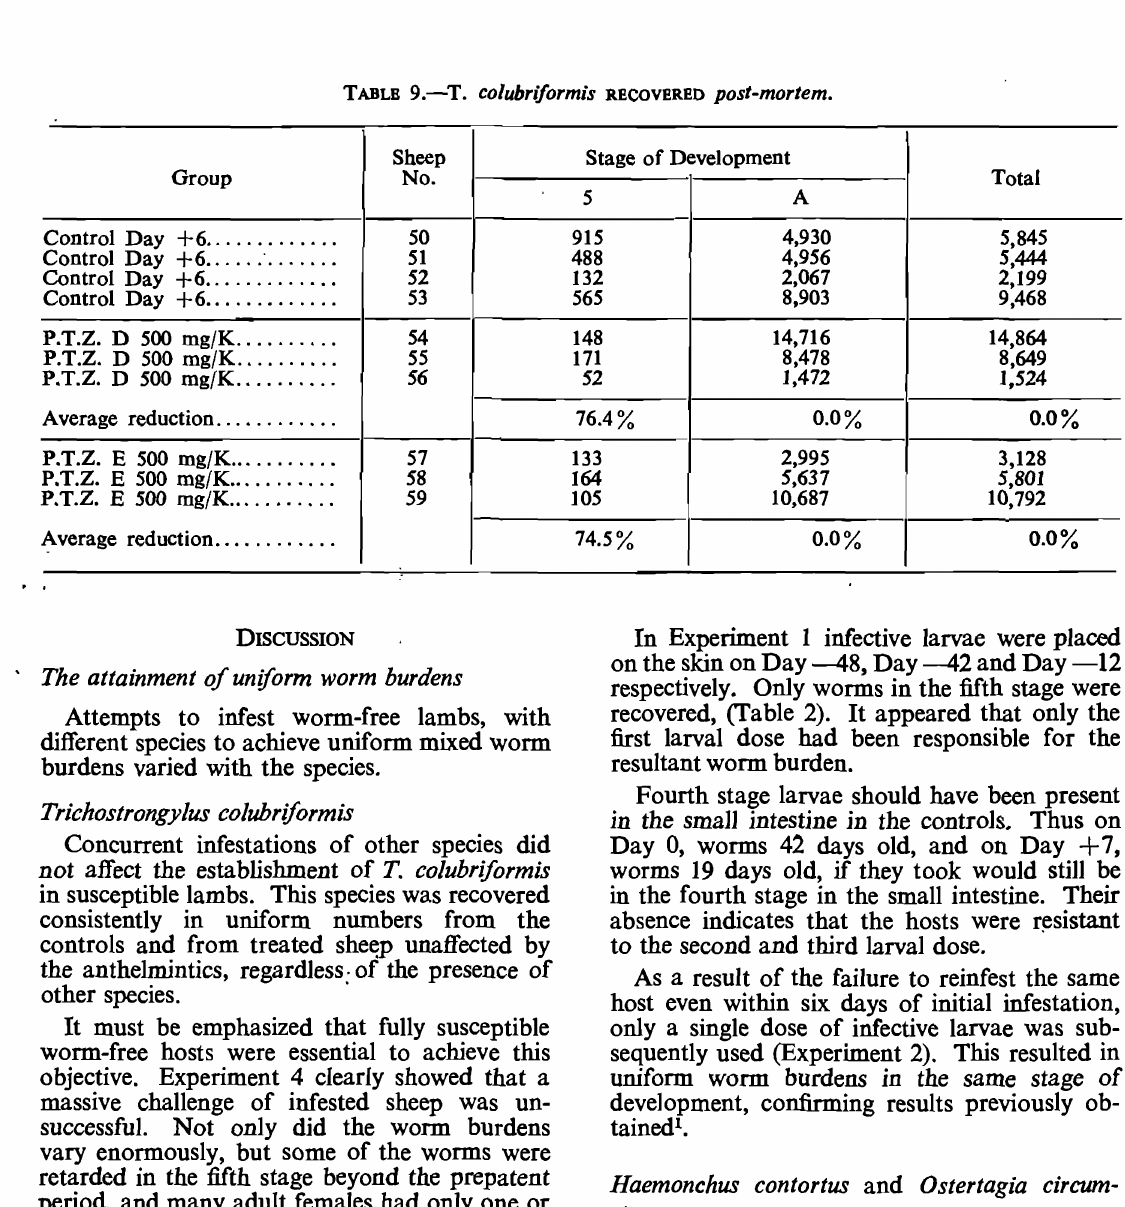
TABLB 9.-T. coiubTl1ormis RECOVERED